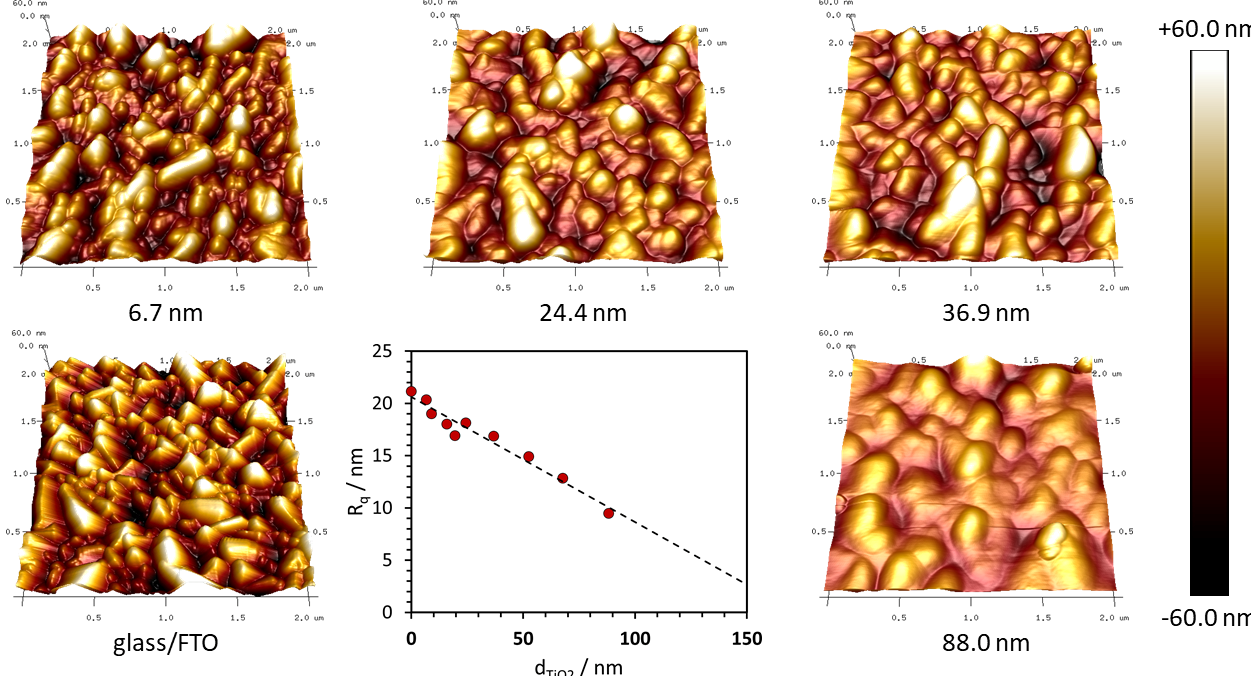
Figure 4. The dependence of the root mean square surface roughness (Rq) on the thickness of the c-TiO 2 layer deposited on